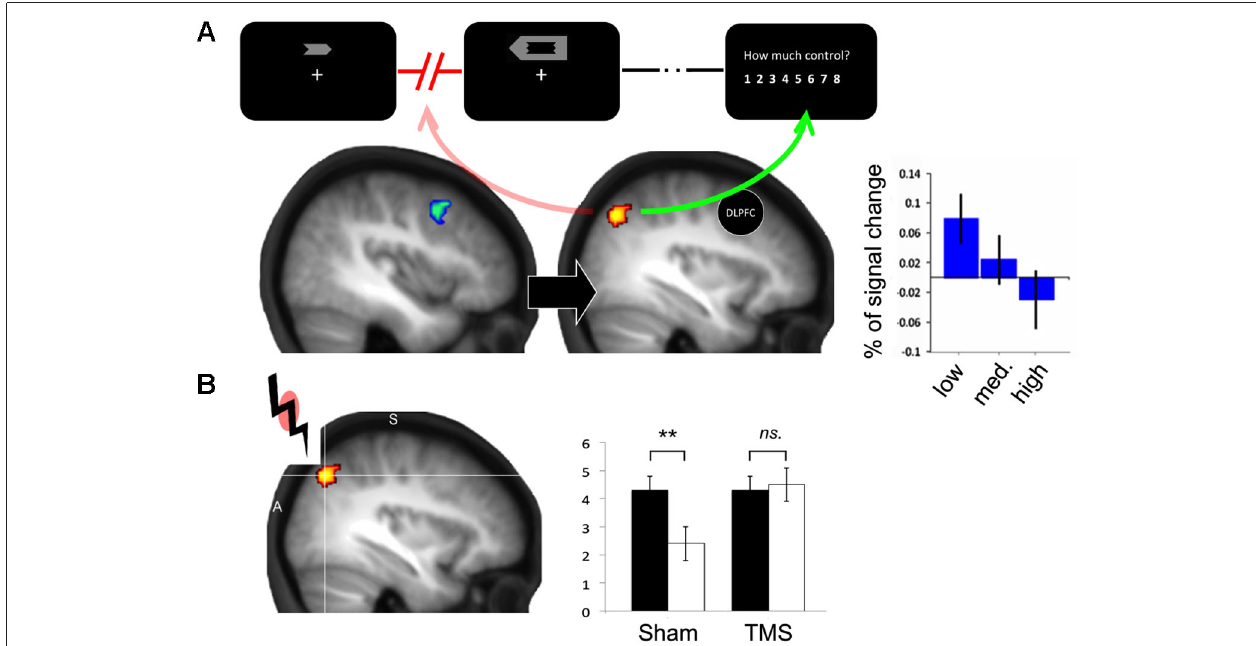
modulation of AG activity as a function of the level of experienced control (from low to high; adapted from Chambon et al., 2013). (B) TMS-induced disruption of left AG at the time of action selection abolishes the compatibility effect on sense of agency (right